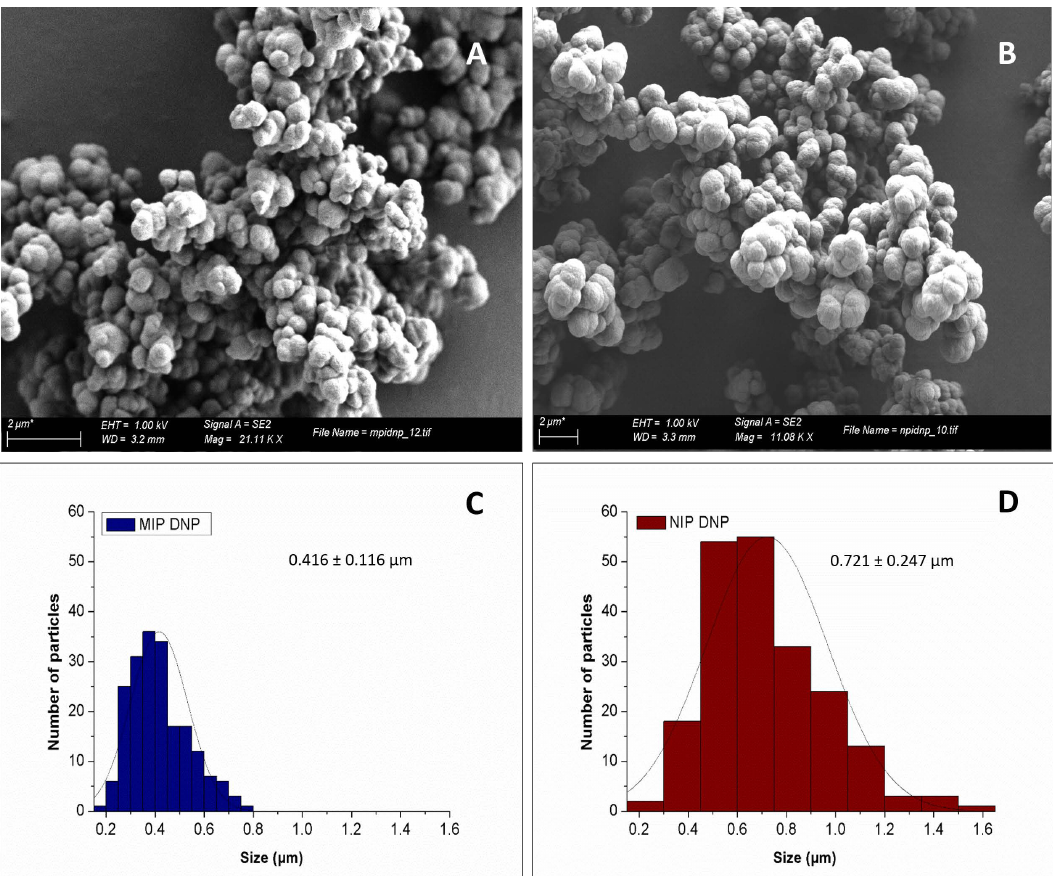
Figure 2. Characterisation of the polymers for MIP ( A , C ) and NIP ( B , D ): scanning electron microscopy (SEM) with secondary electron ( A , B ) and size distribution of the particles ( C , D